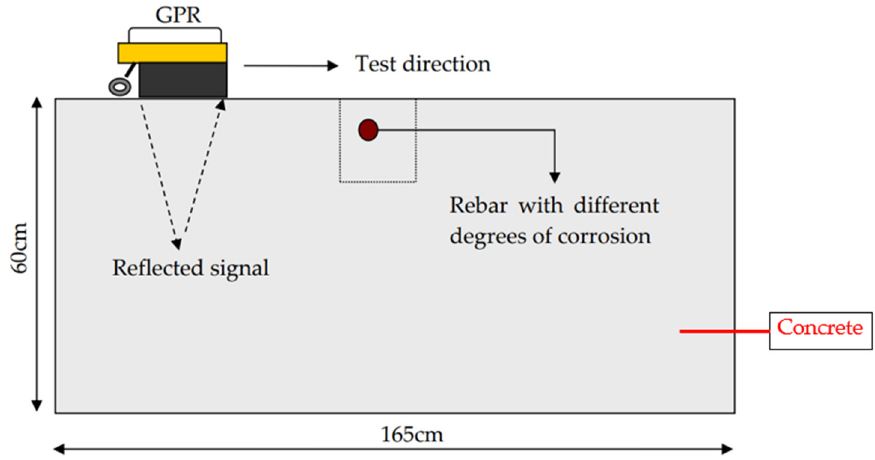
Figure 7. Measurement of Degree of Corrosion by GPR Scanning.